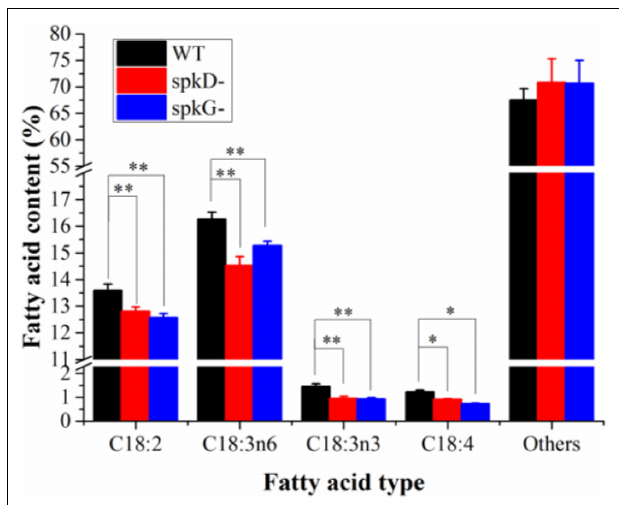
FIGURE 5 | Fatty acid composition and content in spkD and spkG knockout mutants. Data are the mean values of three experiments; the cultivation temperature was 30 ◦ C and the light intensity was 40 µ mol · m − 2 · s − 1 ; WT: Synechocystis sp. PCC6803; spkD -: spkD knockout mutant strain; spkG -: spkG knockout mutant strain. Values are means ± SD (bars) of three independent experiments conducted on different days. The absence of a bar indicates that the SD falls within the symbol. Asterisks mark statistically ( t -test) significant differences from the WT value ( ∗∗ p < 0.01; ∗ p <